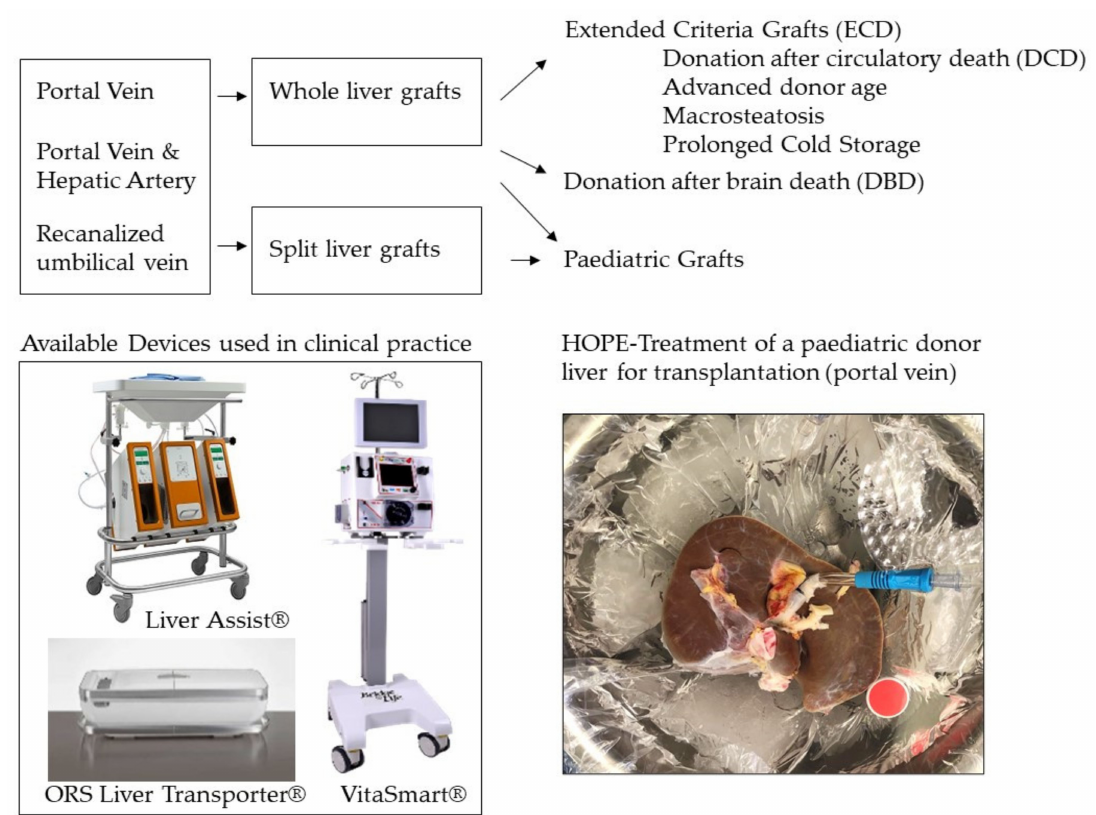
Figure 2. Overview on hypothermic liver perfusion in clinical practice. There is clinical evidence for a protective effect of the HOPE concept in various liver types, including ECD grafts and pediatric